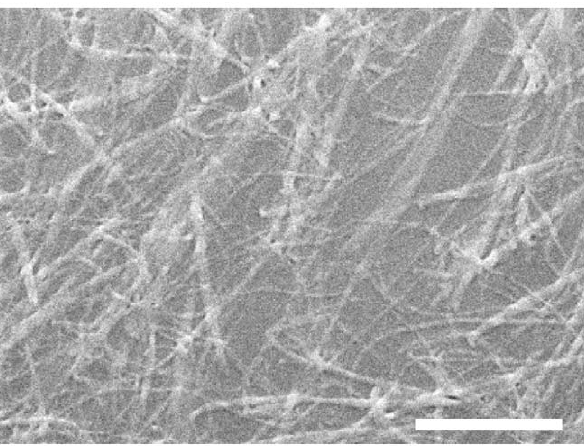
Figure 1. Self-assembly of Type I collagen on a tissue culture plastic substrate leads to a thin fibrillar coating. Scanning electron microscopy of the bioimimetic fibrillar type I collagen coating shown prior to cell seeding (scale bar: 5 m m).